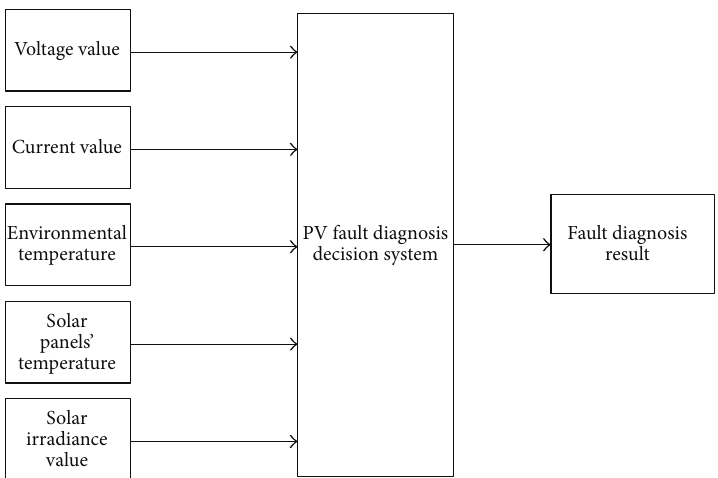
Figure 3: Group decision-making system for PV array